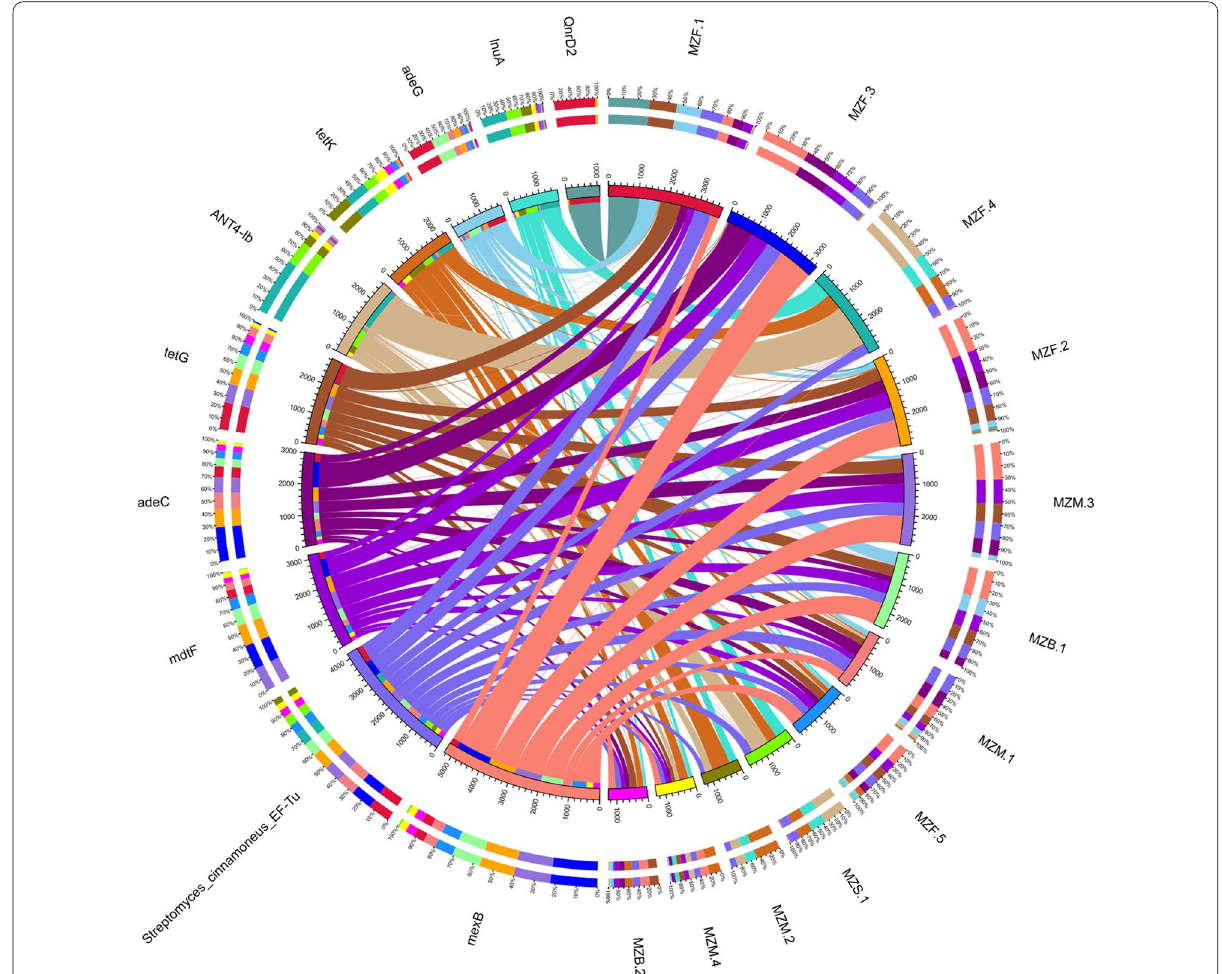
Fig. 11 The overview circle graph of resistance